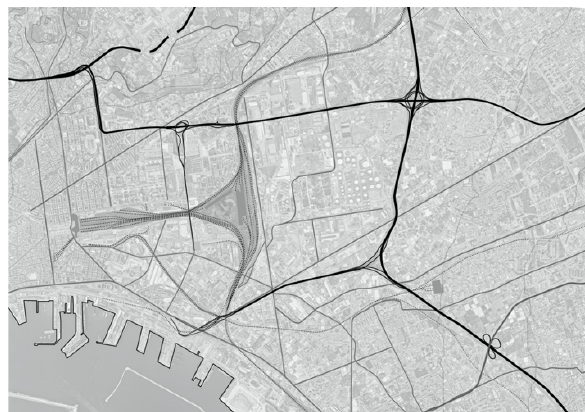
Figure 2 . The East Side of Naples. The main infrastructural lines are